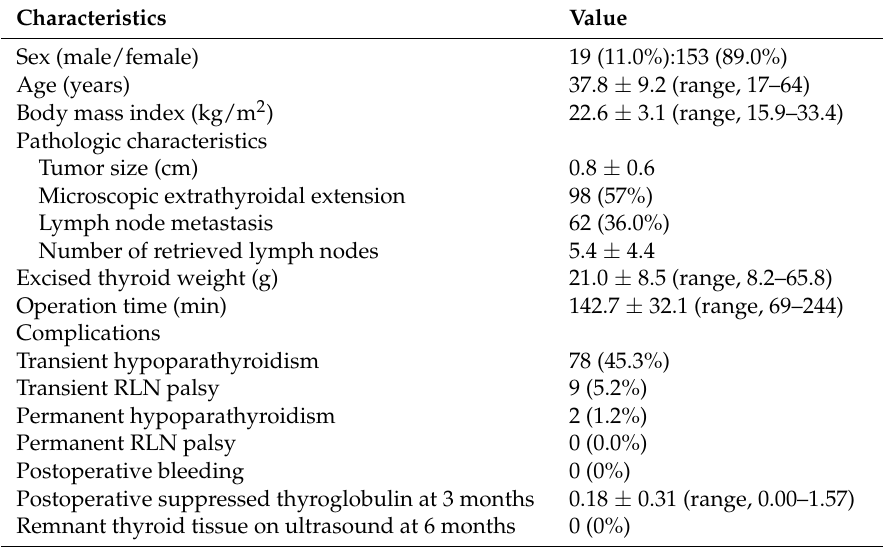
Table 1. Clinicopathological characteristics of the